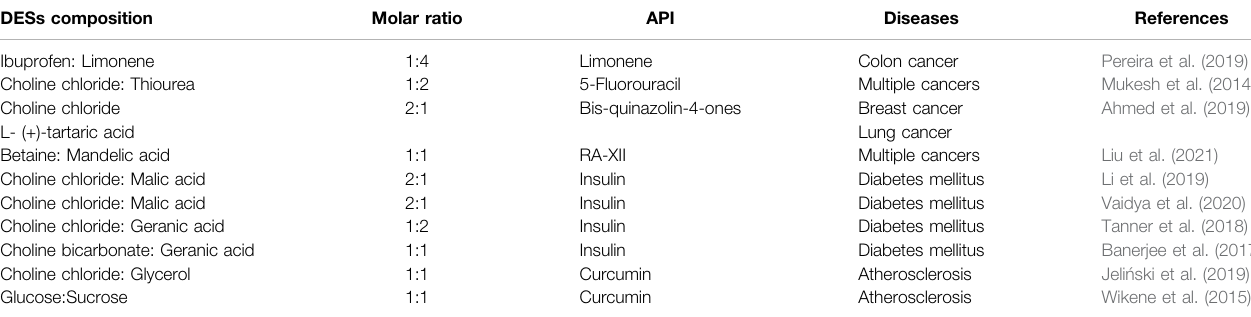
TABLE 3 | The composition and proportion of DESs in the treatment of metabolic related diseases. DESs composition Molar